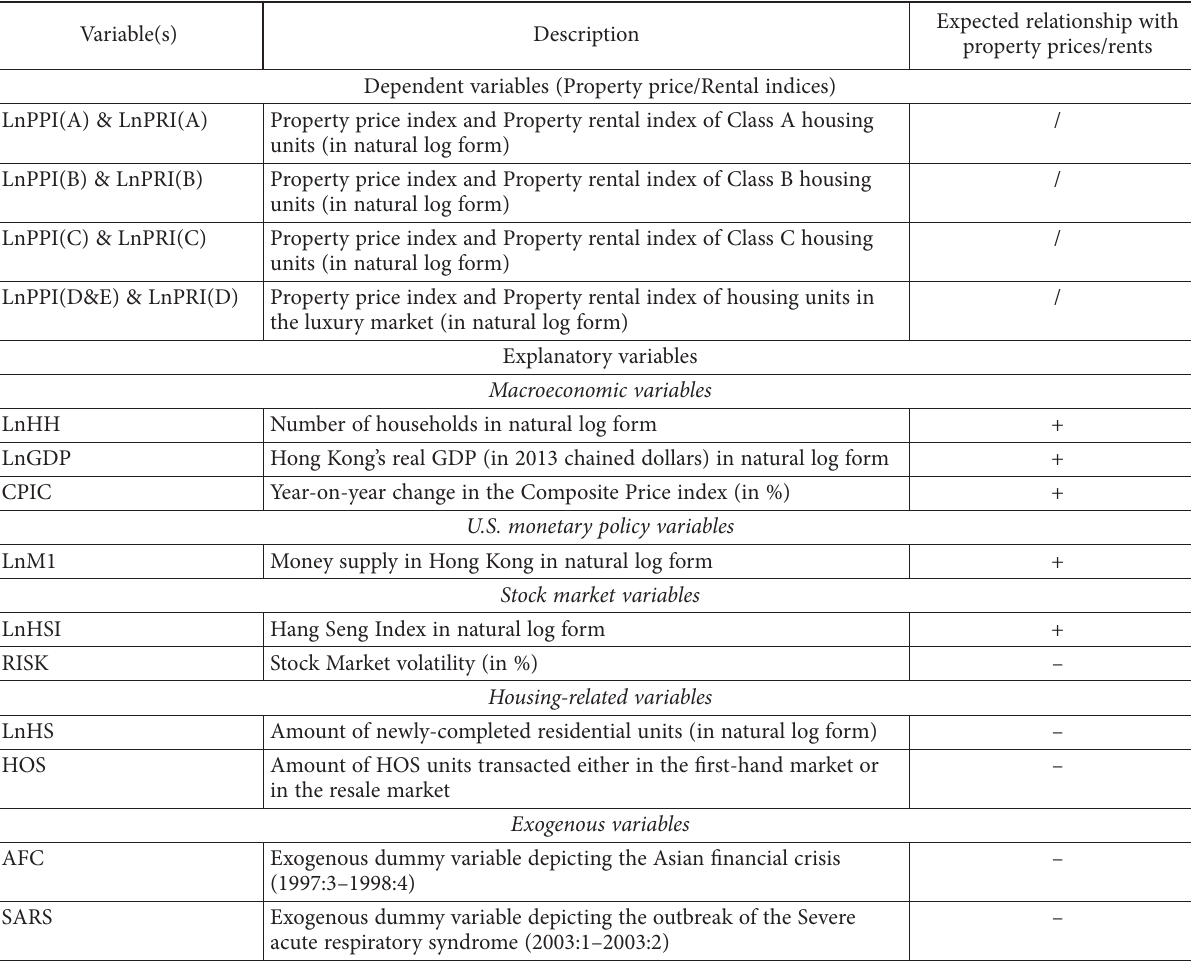
Table 1. Description of selected variables